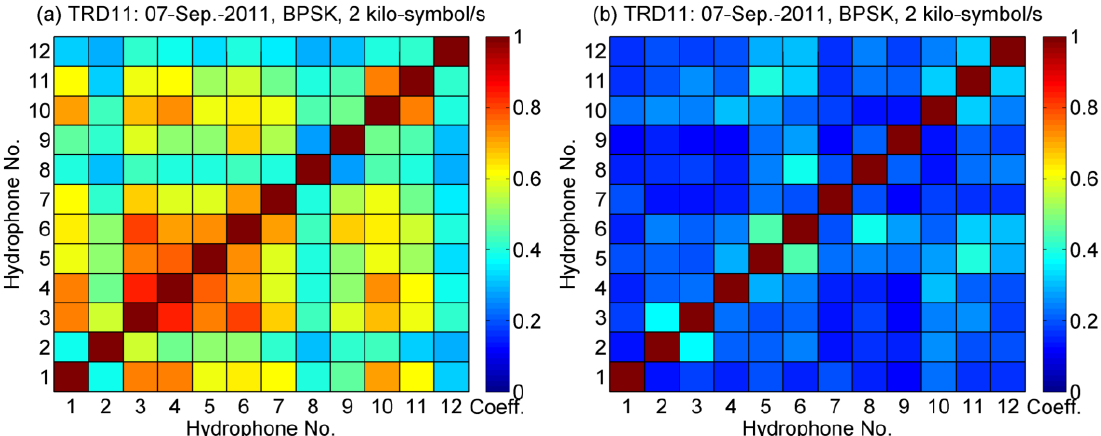
Figure 11. Spatial coherence in different periods. ( a ) The 3rd period; ( b ) The 11th